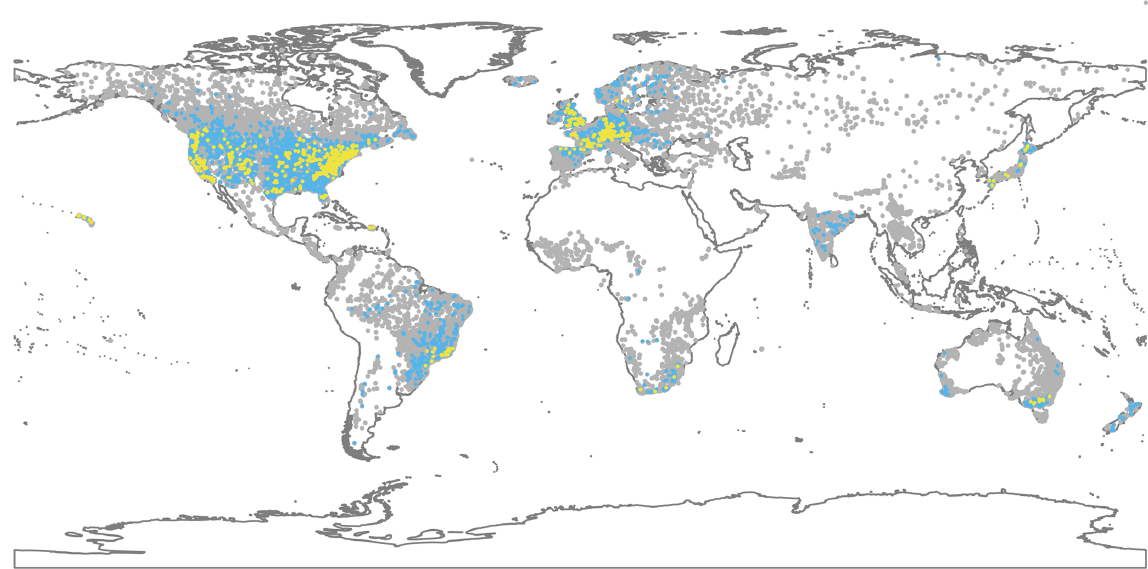
Figure 2. Locations of 3666 streamflow observations (blue dots: 3024 non-averaged time series; yellow dots: 624 averaged time series, where geographical coordinates were averaged from all component gauging coordinates) selected from GSIM archive for the model–observation comparison. Grey dots indicate GSIM time series that were removed due to insufficient data availability or